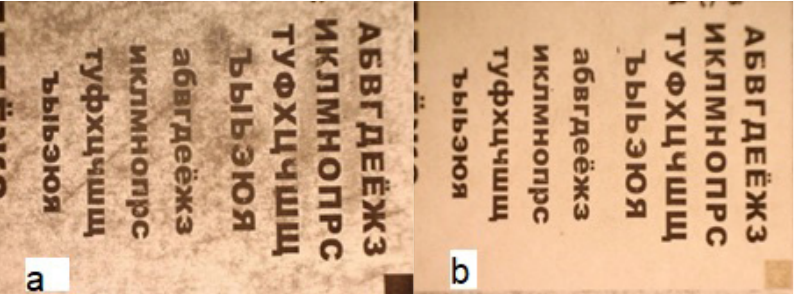
Figure 9. A model sample of paper with simulation of contaminants on the surface: ( a )—before cleaning, ( b )—after laser treatment.